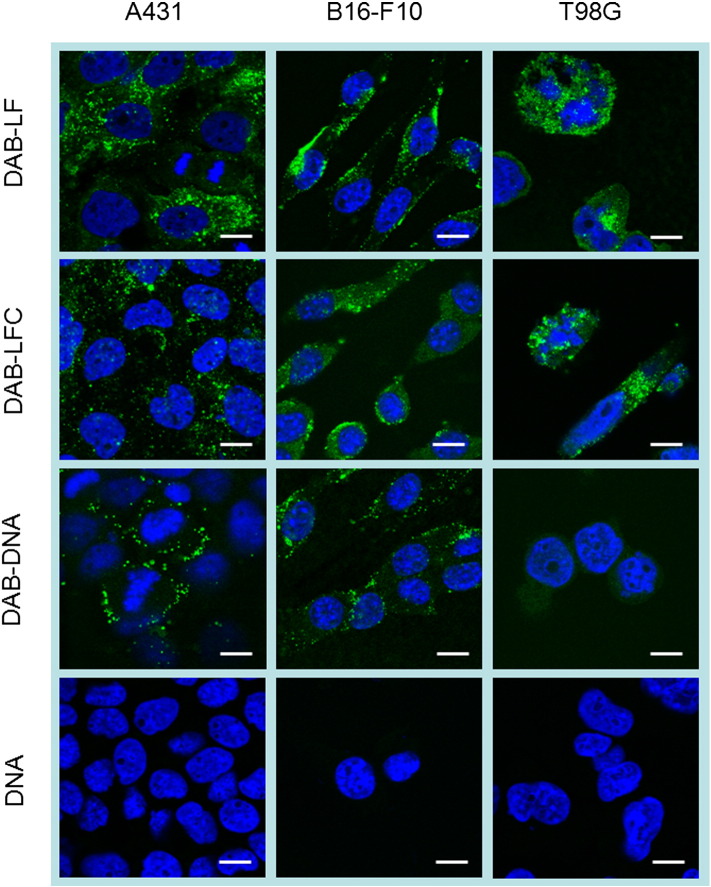
Confocal microscopy imaging of the cellular uptake of Cy3- labeled DNA (2.5 μg/well) either complexed with DAB-LF, DAB-LFC, DAB or in solution, after incubation for 24 h with A431 (left), B16-F10 (middle) and T98G cells (right). Blue: nuclei stained with DAPI (excitation: 405 nm laser line, bandwidth: 415-491 nm), green: Cy3-labeled DNA (excitation: 543 nm laser line. bandwidth: 550-620 nm) (Bar: 10 μm).